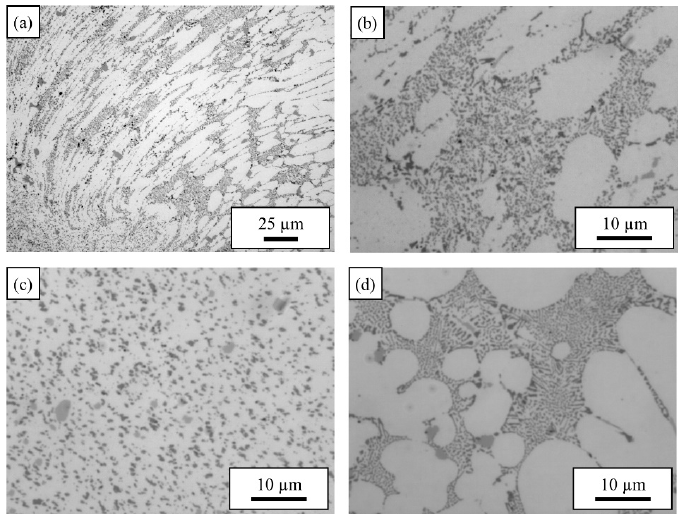
Figure 6. Detail of cross-section of AlSi10MnMg alloy at 500 mm/min: ( a ) TMAZ; ( b ) HAZ; ( c ) WN; and ( d ) base material.